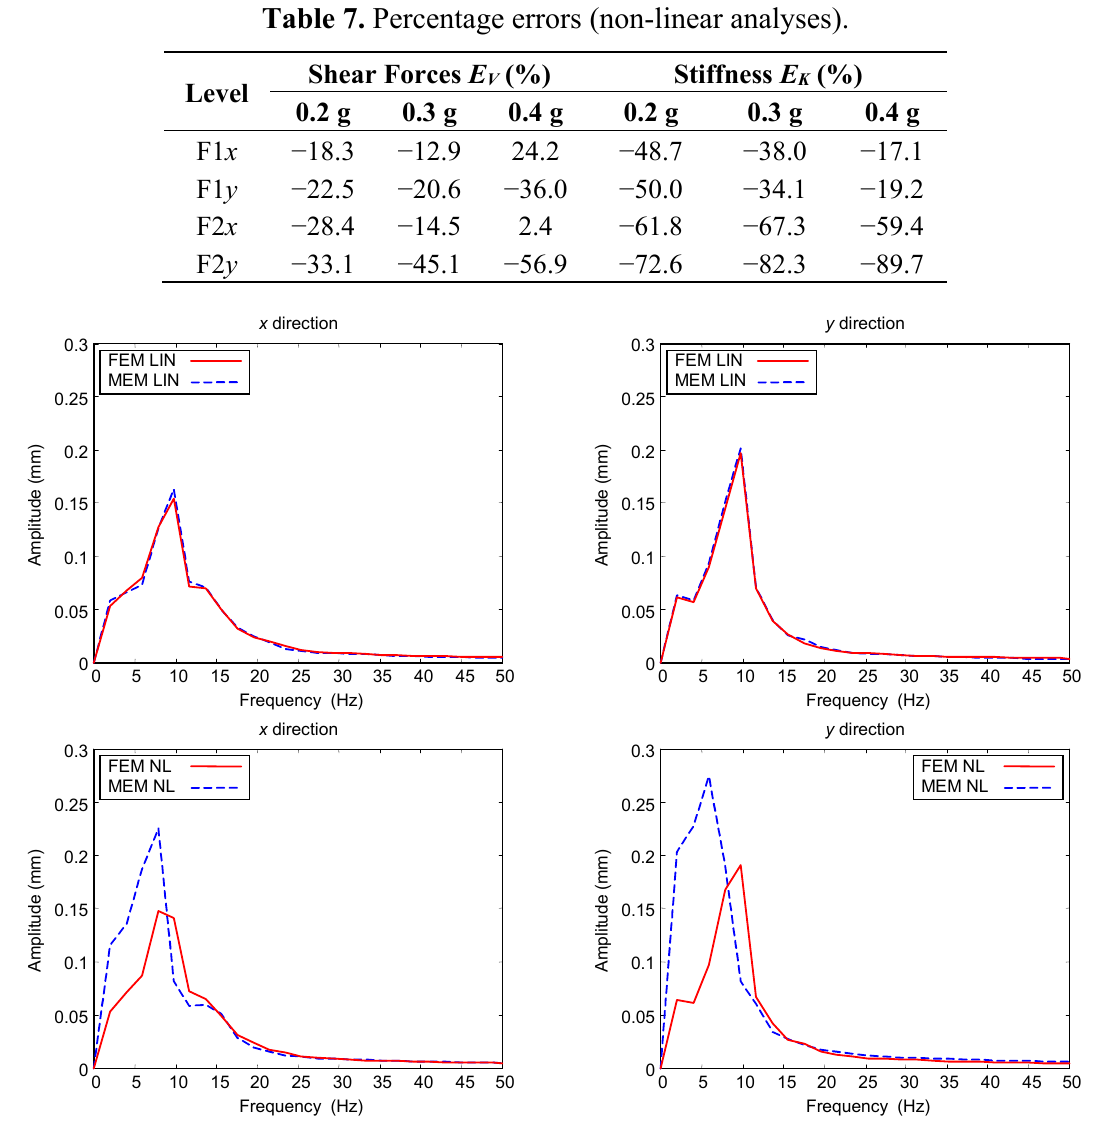
Figure 17. Displacement amplitude spectra of the second floor for linear and non-linear analyses with nominal PGA = 0.30